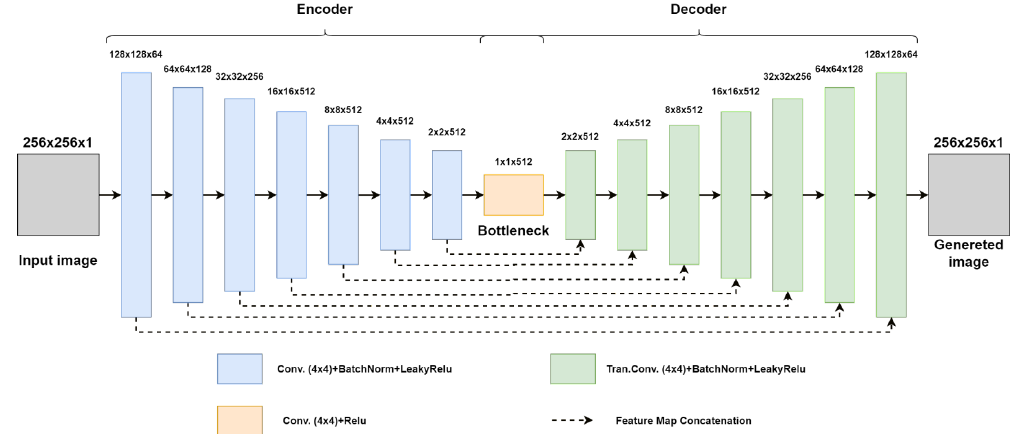
Figure 2. Structure of the proposed